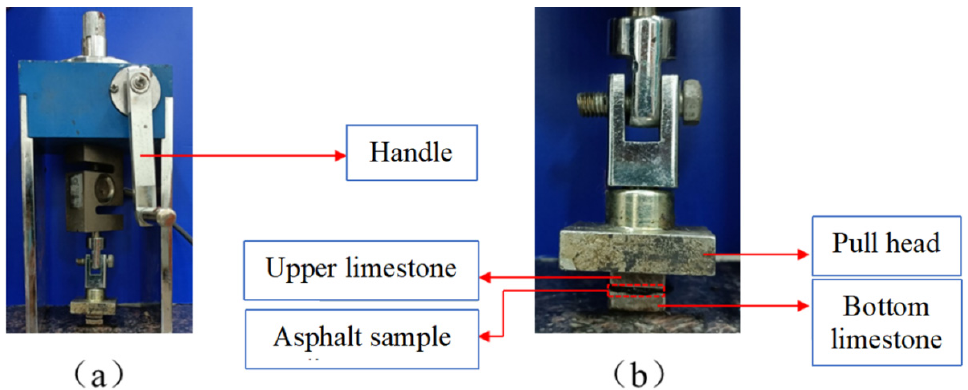
Figure 8. ( a ) The photo of the pull-off instrument; ( b ) The photo of asphalt sample and the pull